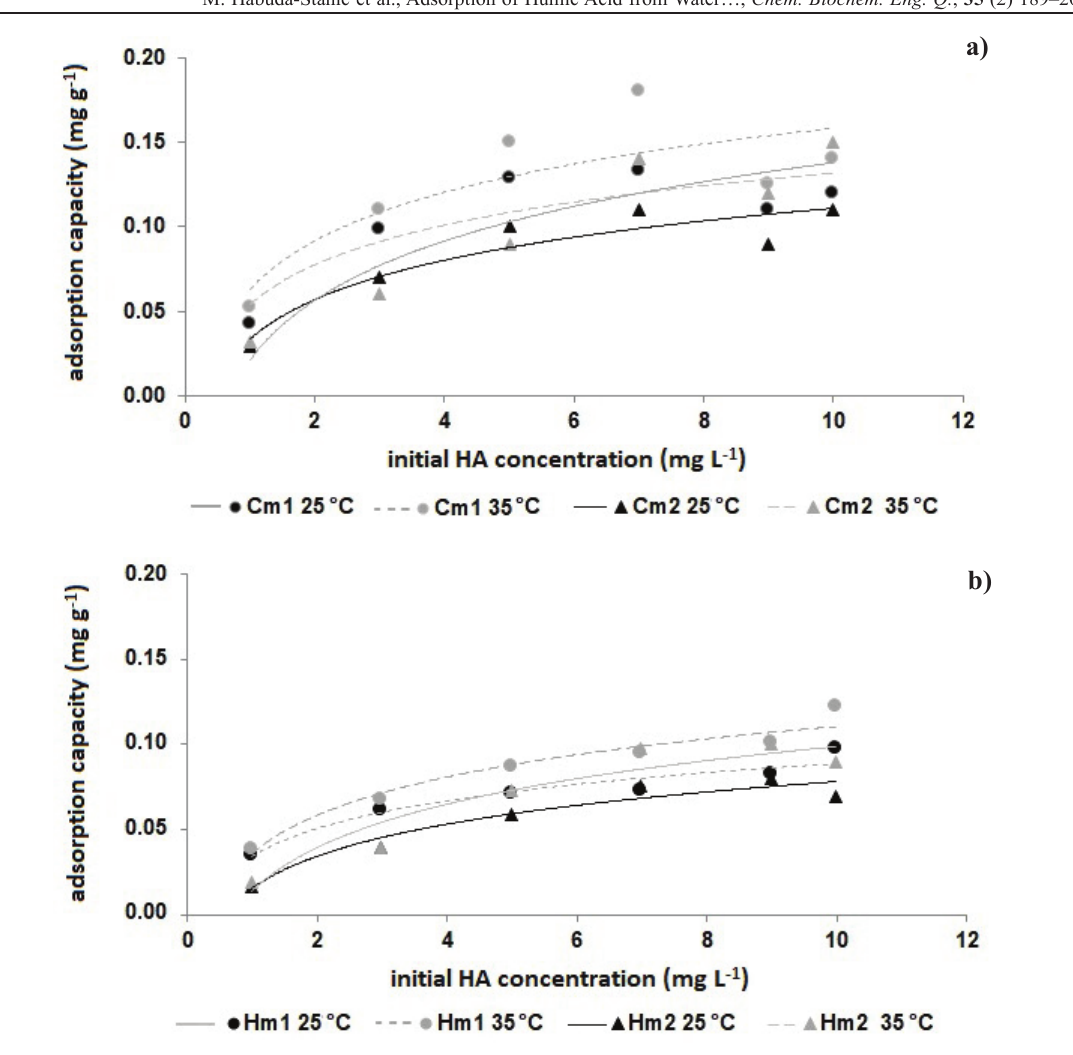
Fig. 4 – Effects of initial HA concentration on adsorption capacity of (a) Cm1 and Cm2, and (b) Hm1 and Hm2 (γ = 1 g L –1 , T = 25 °C and 35 °C, V ads